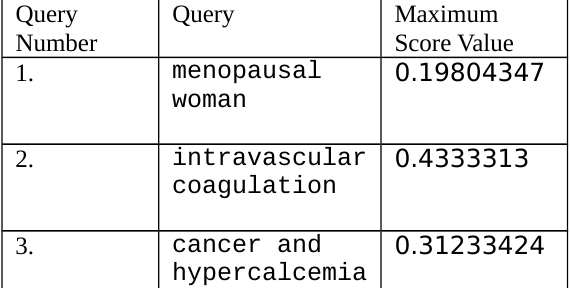
Table 1 . Fuzzy Queries tested on TREC dataset and their respective scores with the proposed similarity